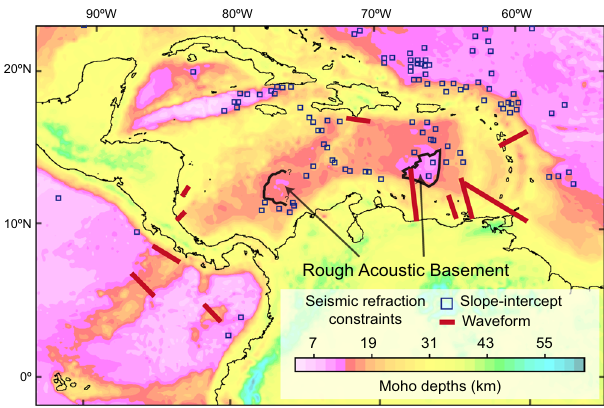
Fig. 2 Moho depth map from this study based on the inversion of gravity and seismic constraints (shown by small squares). The two thicker black lines show the boundaries of the smooth- rough acoustic basement that re fl ect the transitions from over thickened to regular thickness oceanic lithosphere. For comparisons to other published Moho models, see Supplementary